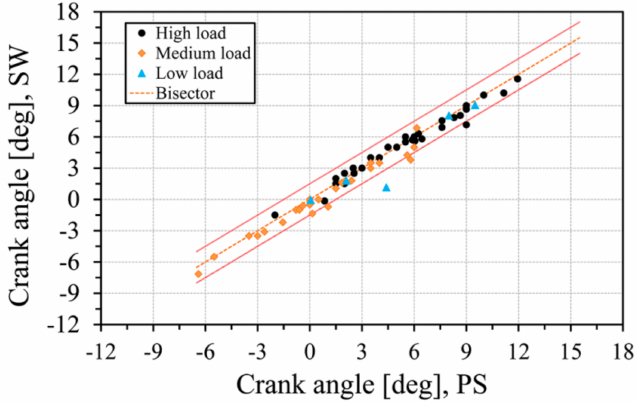
Figure 14. MBF50 evaluated by the strain washer and the pressure sensor at different operating conditions in terms of load and regime (from 3000 to 6000 rpm) on the average-cycle.